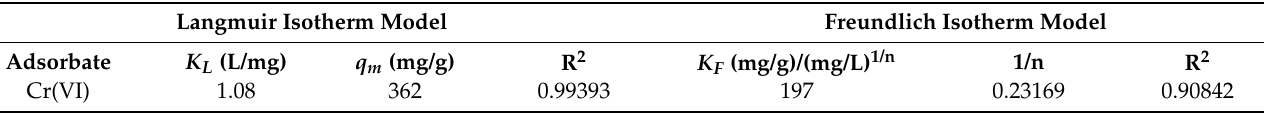
Table 1. The parameters of isotherm models for removal of Cr by PEG@PTHA. Langmuir Isotherm Model Freundlich Isotherm Model